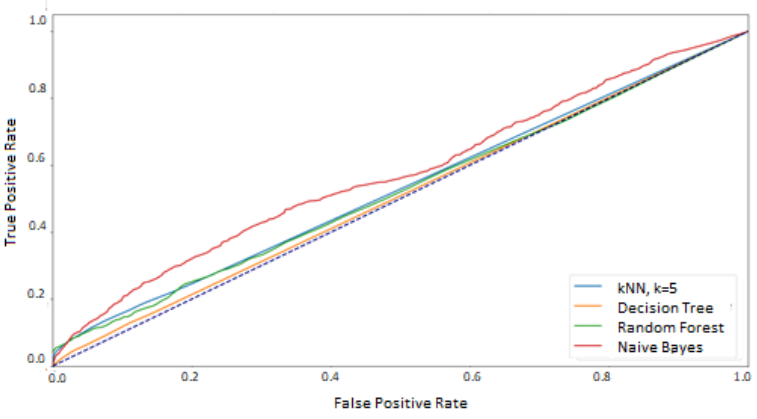
Figure 12. ROC–macro averages. The train and test sets based on the different